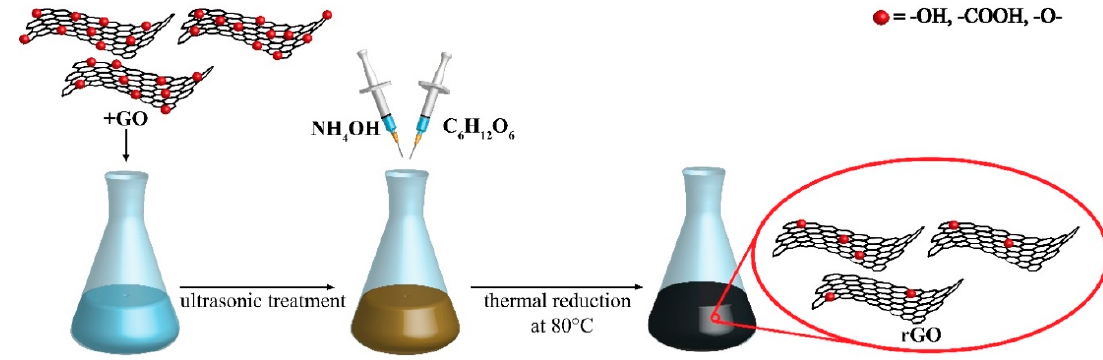
Figure 10. Schematic representation of glucose-NH 4 OH thermal reduction of GO to rGO.